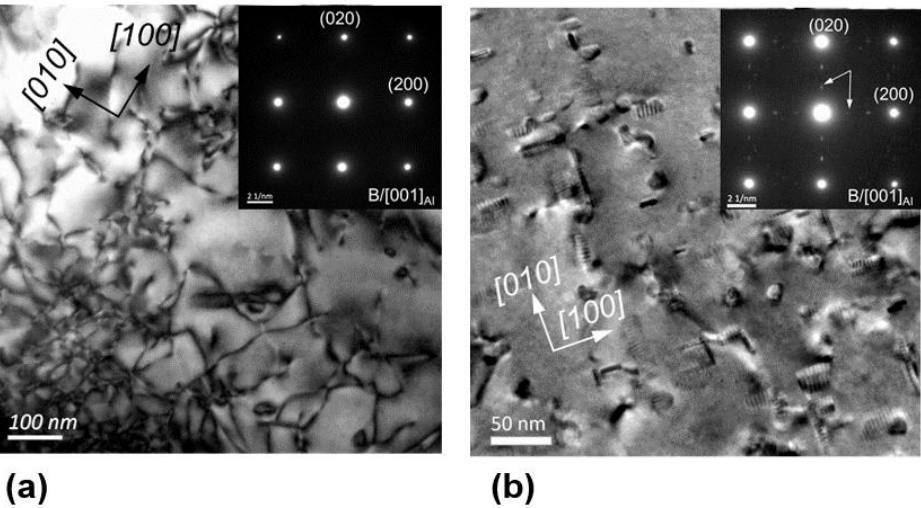
Figure 10. TEM bright-field images and corresponding SAED patterns (insets) showing dislocations and precipitates in an Al-Si-Cu alloy prepared with intensive melt shearing. Dislocations are prevalent in the as-cast material ( a ), while many precipitates are observed after T5 aging treatment ( b ). Reprinted with permission from Ref. [53]. Copyright 2022, Elsevier.